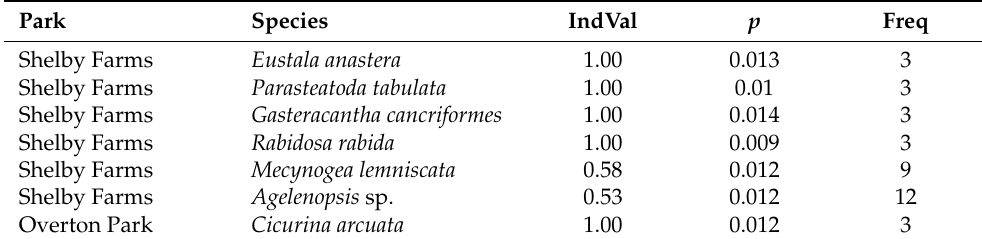
Table 2. IndVal analysis of species that are associated with specific parks based on the specimens we collected in the summer of 2022. Only significant ( p < 0.05) habitat associations are presented. The significance of IndVal indices was assessed using 10,000 Monte Carlo permutations.